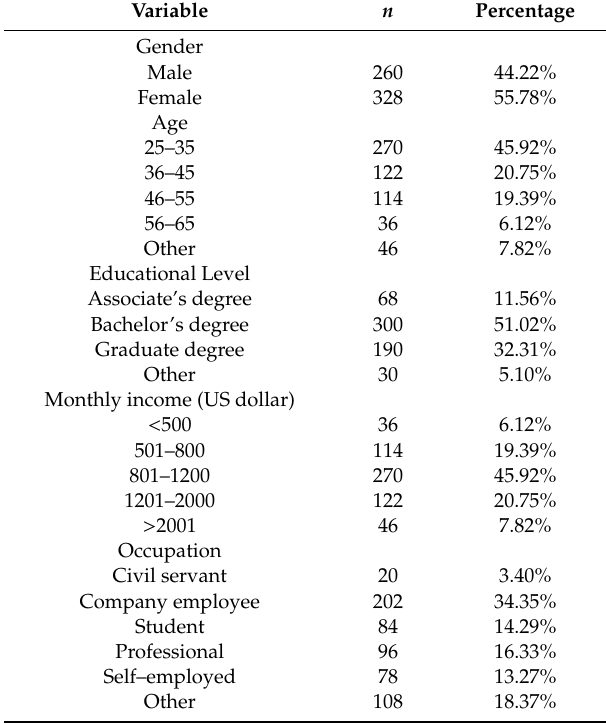
Table 2. Profile of survey respondents ( n = 588).